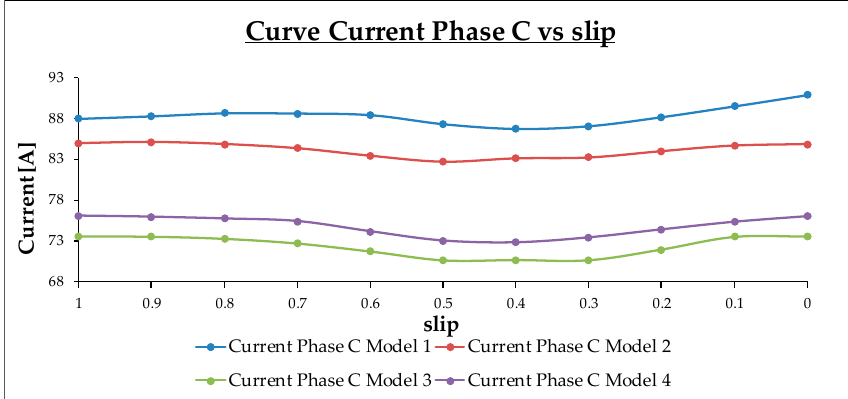
Figure 34. Electric current phase C versus slips.